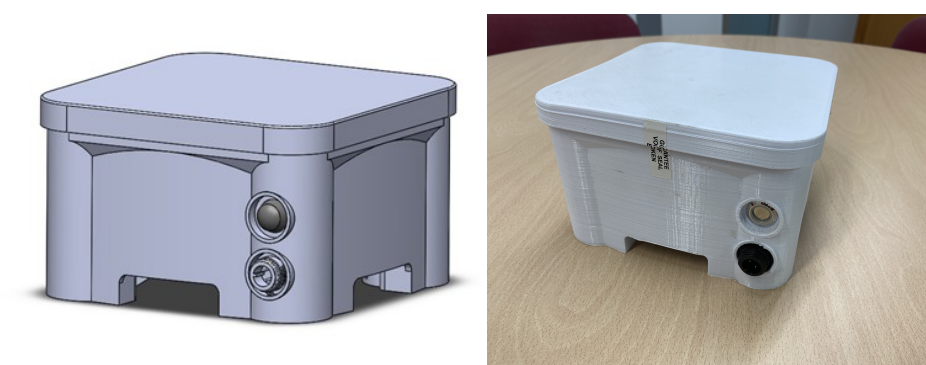
Figure 6. Polluting gas measuring